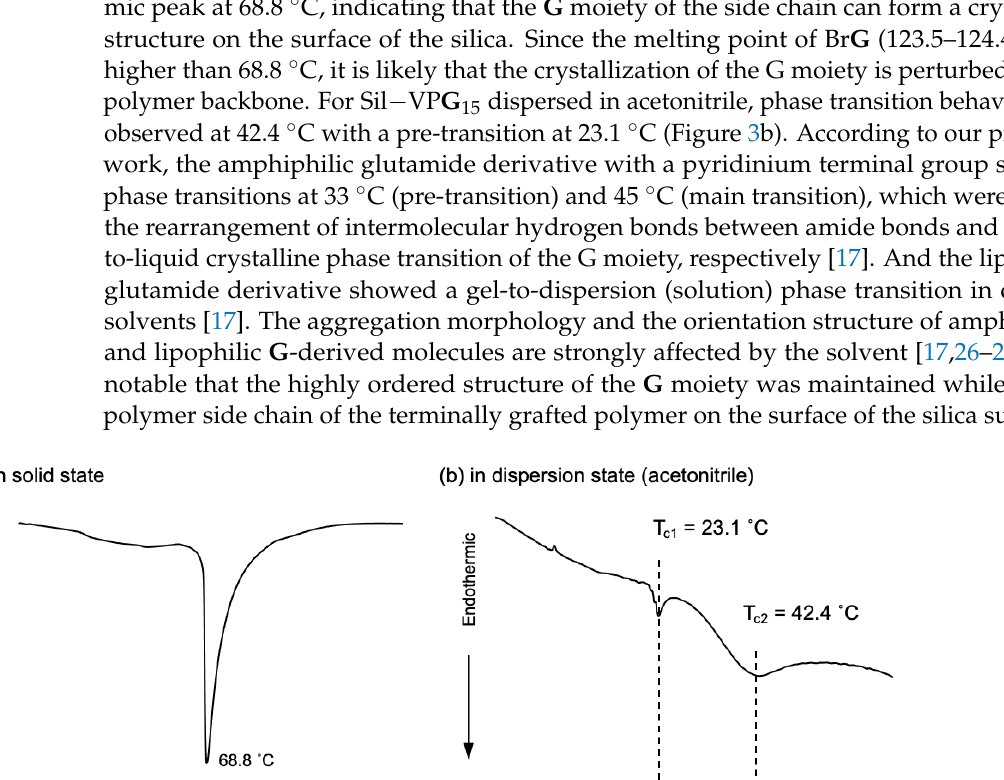
Figure 4. Relationships of log k and log P for ( a ) Sil−VP G 15 and ( b ) ODS. Mobile phase: Acetonitrile. Flow rate: 1.0 mL min −1 . Detection wavelength: 254 nm. Column temp.: 25 °C.